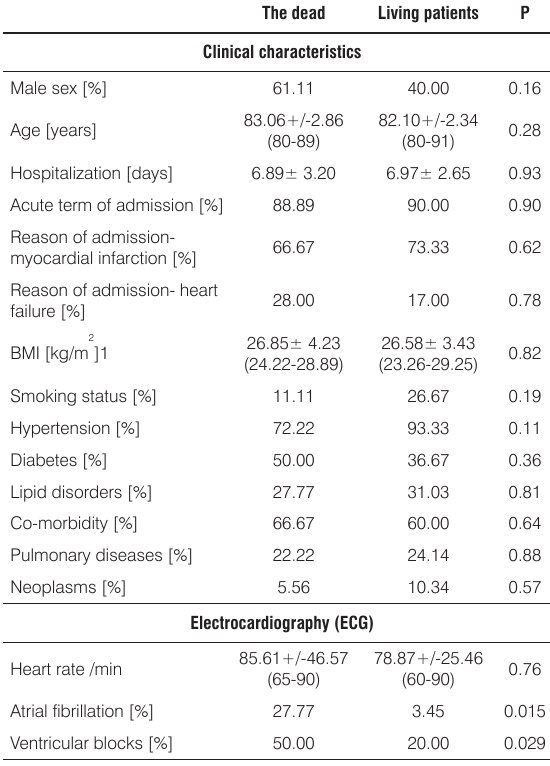
Table 1. Clinical and electrocardiographic characteristics of the studied groups.